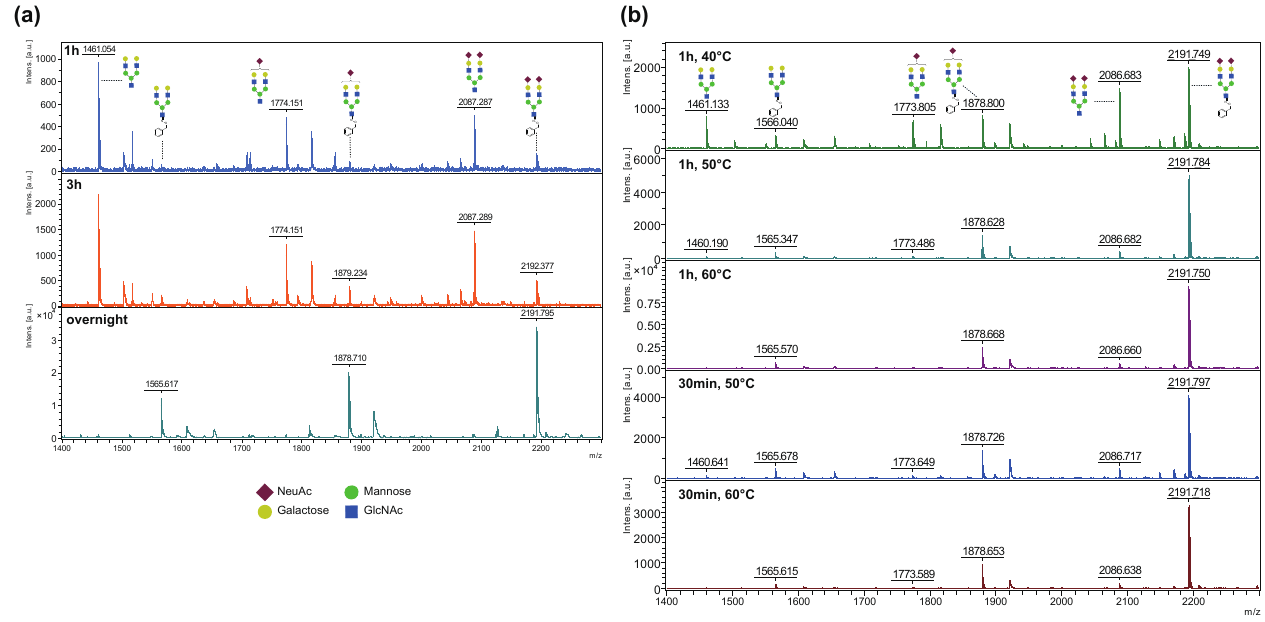
Figure 4. MALDI–TOFMS spectra of SGP-10 (5 pmol/spot) with the BOA/DHB/Na matrix system spotted on the AnchorChip TM MALDI target plate (laser power 40%, 500 shots, random walk mode): ( a ) comparison of the spectra with different crystallization times at room temperature; ( b ) comparison of the spectra with different crystallization conditions in an